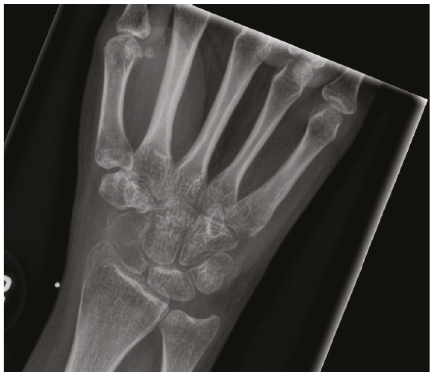
Figure 1: Diagnostic AP XR. AP radiograph of the right wrist, demonstrating radiolucency within the